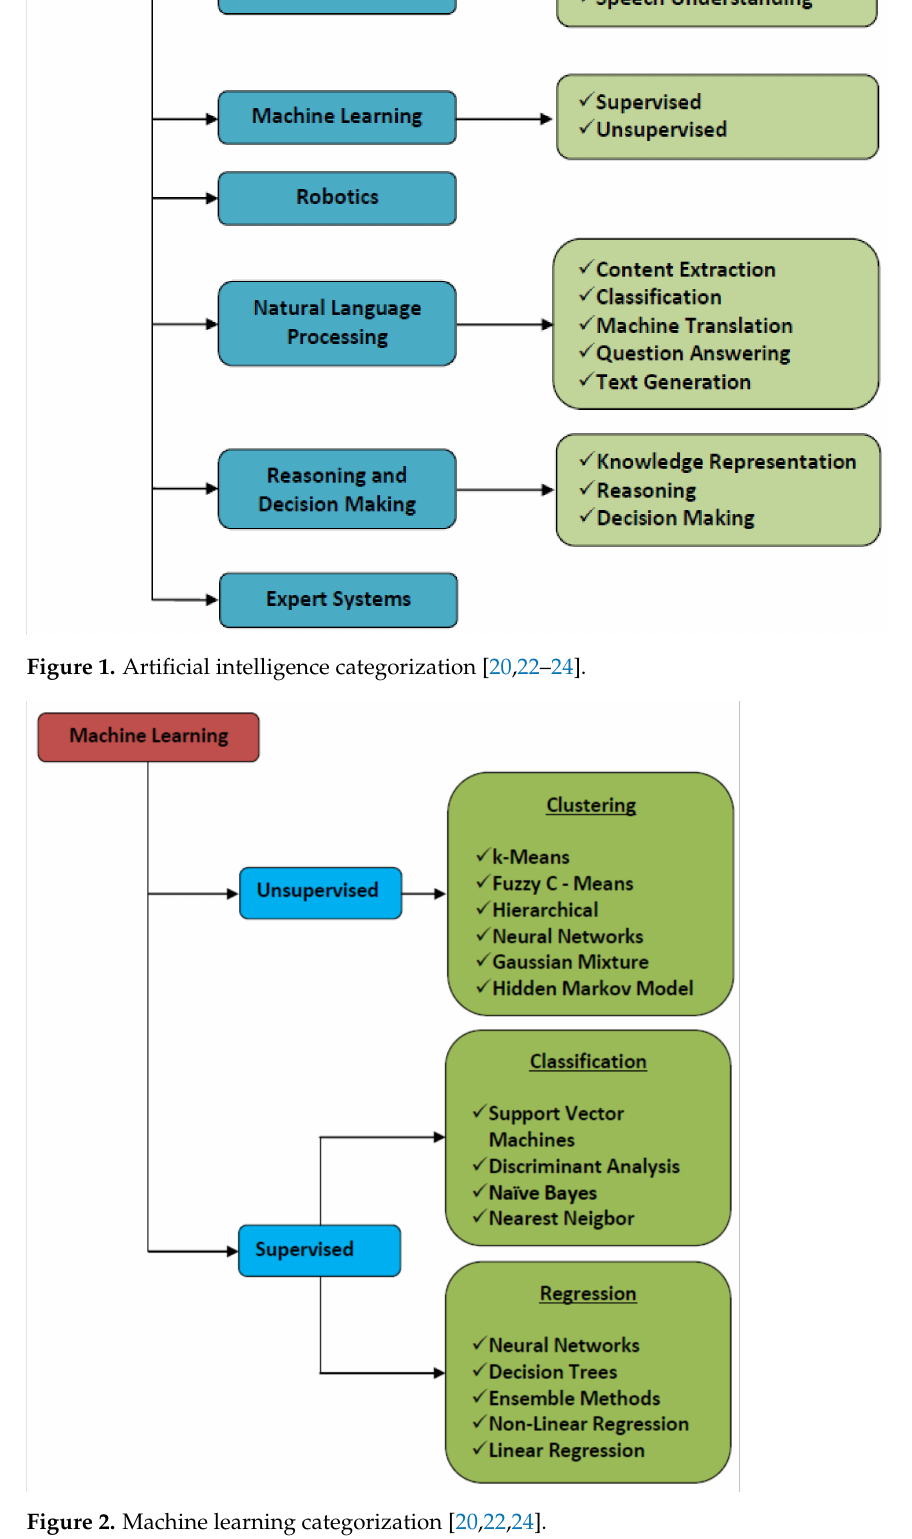
Figure 2. Machine learning categorization